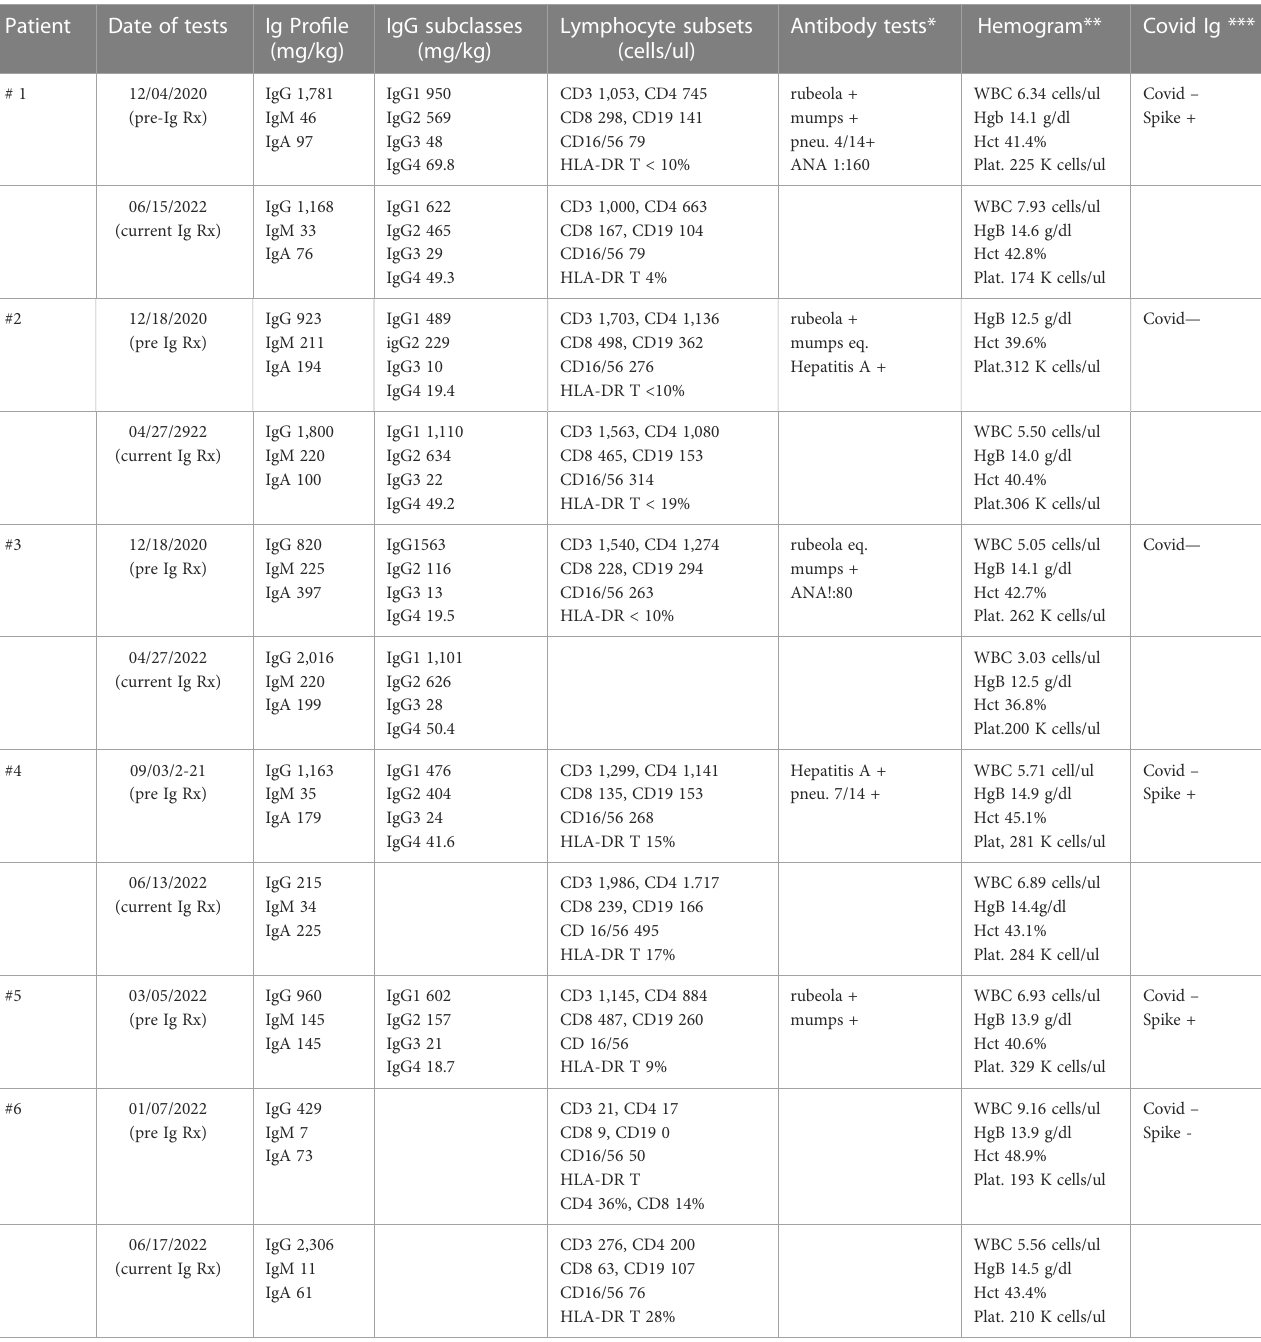
TABLE 2 Laboratory